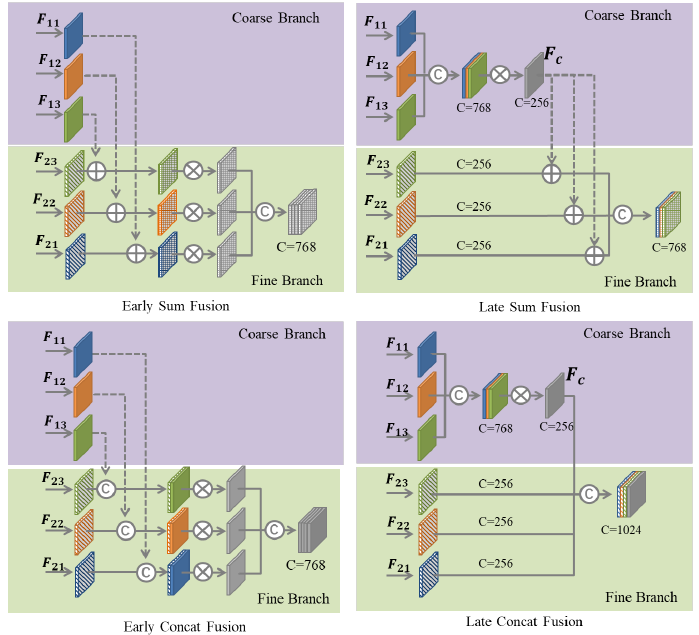
Figure 7. Different fusion methods of the two branches, where C represents concatenation, ⊕ represents the element-wise summation, and ⊗ represents the convolutional layer.